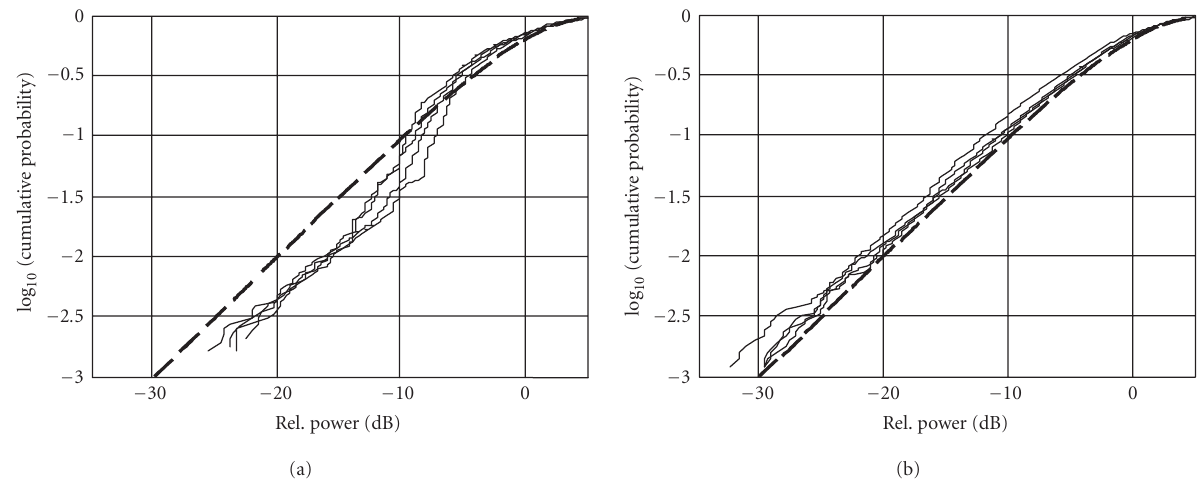
Figure 7: Comparison between CDFs of (a) a weak early tap (first tap BS3, average power = − 9 . 8dB) and (b) a stronger next tap (second tap BS3, excess delay = 73 nanoseconds, average power = − 1 . 7dB) in the outdoor campaign. Dashed lines indicate CDF of power of Rayleigh distributed process.